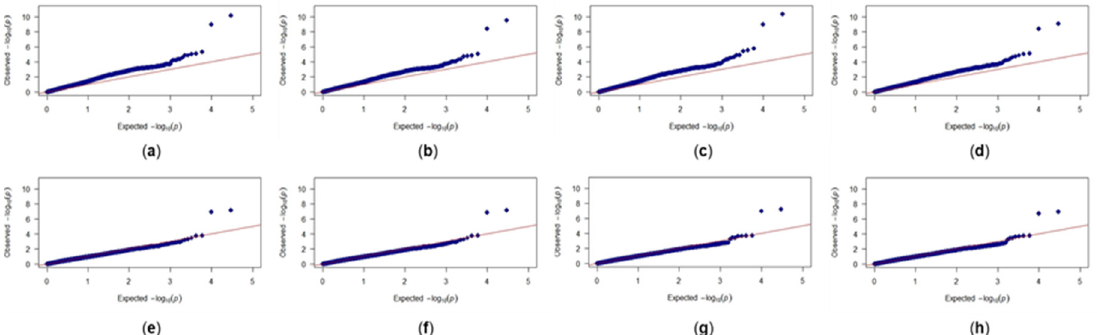
Figure 3. Quantile-quantile plots for bran friability trait: ( a ) General linear model (GLM) with no covariates; ( b ) GLM with bran yield (BY) as covariate; ( c ) GLM with water retention capacity (WRC) as covariate; ( d ) GLM with BY and WRC as covariates; ( e ) mixed linear model (MLM) with kinship and no covariates; ( f ) MLM with kinship and BY as covariates; ( g ) MLM with kinship and WRC as covariates; ( h ) MLM with kinship and BY and WRC as covariates. red line: X=Y; blue diamonds: actual values.